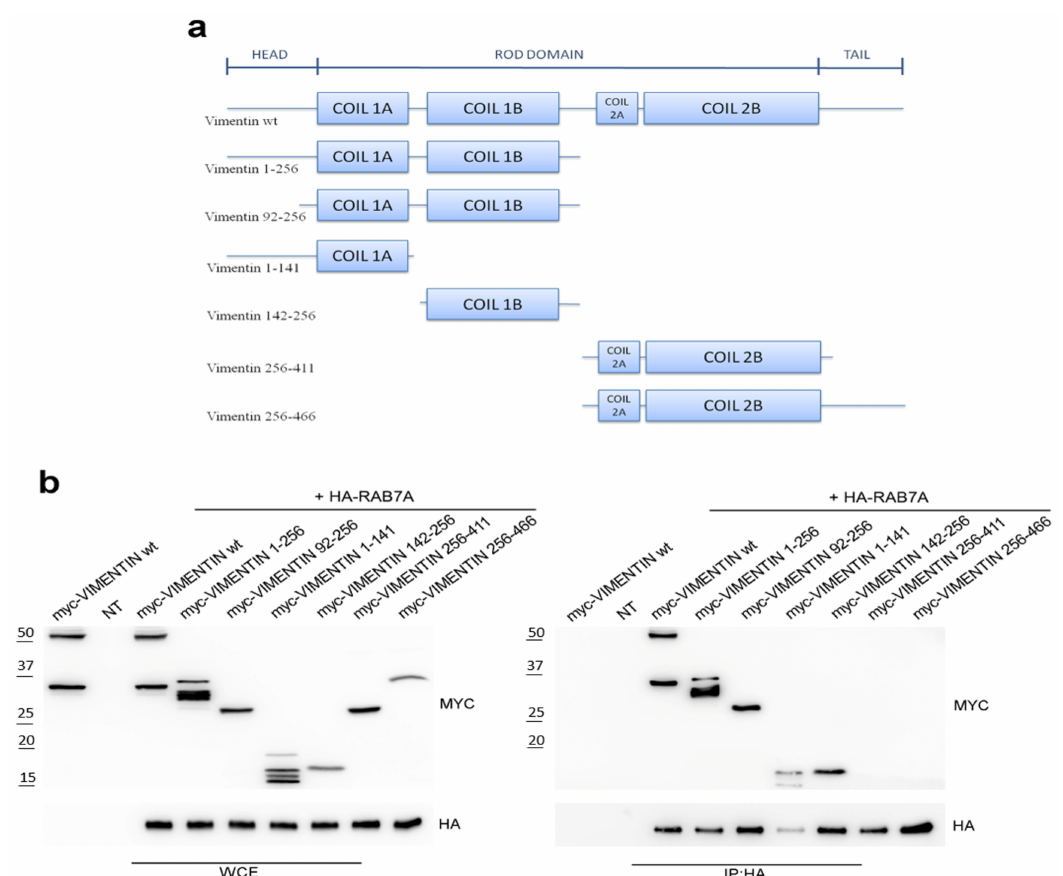
Figure 1. RAB7A interacts with the coil1 domain of vimentin. ( a ) scheme representing the structure of wild type vimentin and its deletion mutants constructed for testing the interaction with RAB7A. ( b ) hemagglutinin (HA)-tagged RAB7A and wild type or mutated myc-tagged vimentin proteins were expressed in HeLa cells as indicated. Immunoprecipitation (IP) has been performed using an anti-HA resin. Immunoprecipitates were subjected to Western blot analysis using anti-myc and anti-HA antibodies. Expression of the proteins of interest in the lysate before performing co-IP has been tested (Whole-Cell extract